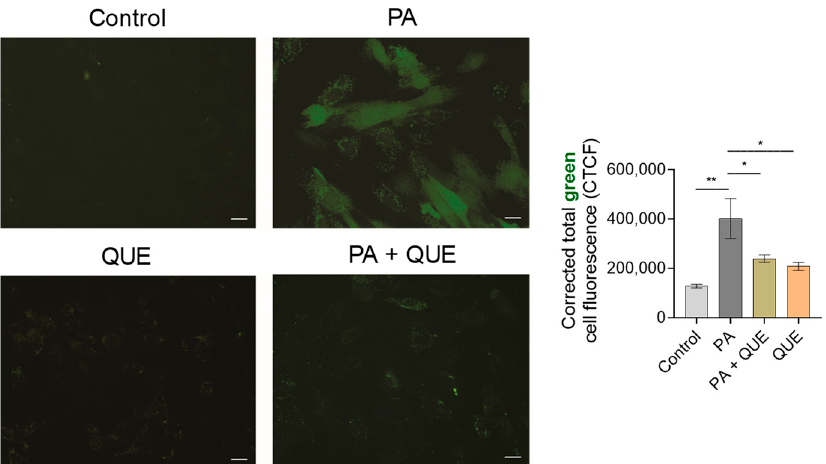
Figure 4. Effect of QUE pre-treatment on PA-dependent ROS overproduction in H9c2 cardiomyocytes. Representative images of a cell-permeable fluorescent probe (CM-H 2 DCFDA) for total ROS detection with relative fluorescence quantification. Data are expressed as the mean ± SEM ( n = 2 different experiments). Significant differences in corrected total cell fluorescence (CTCF) were detected by one-way ANOVA and Newman–Keuls multiple comparison test, p < 0.05 (*) and p < 0.01 (**). Scale bar : 25 µm.